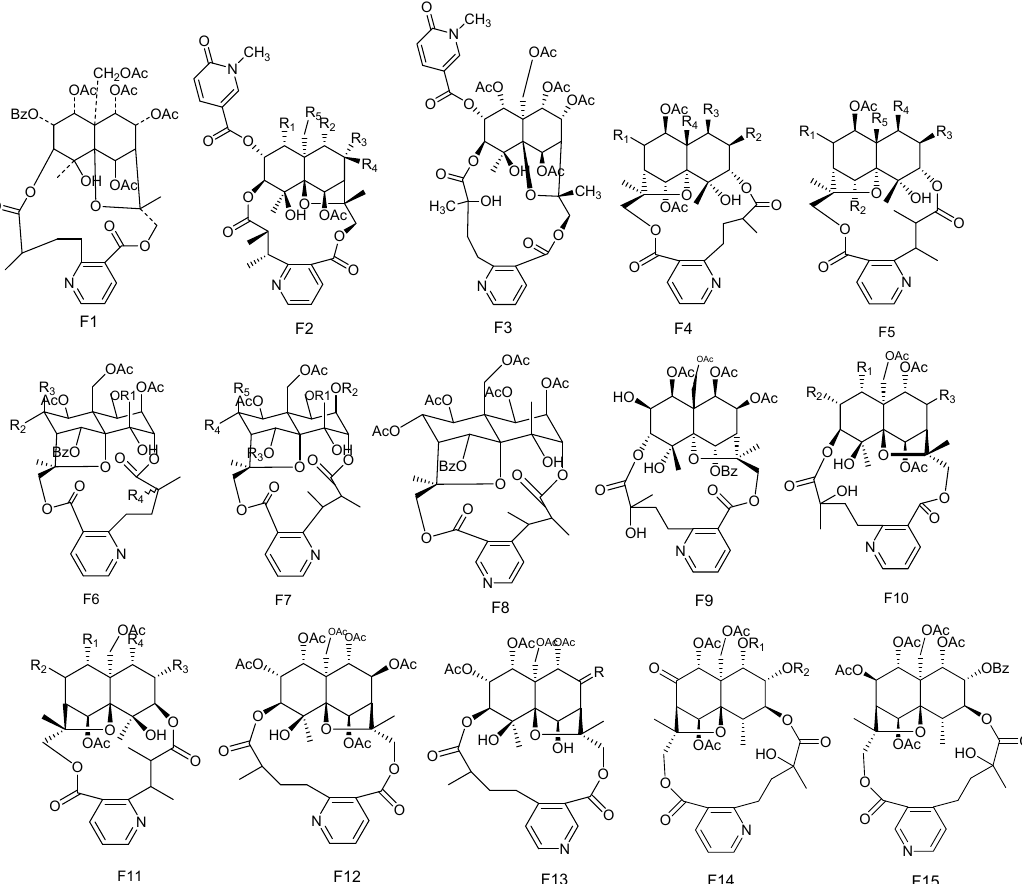
Figure 6. Fifteen types (F1–F15) of sesquiterpene pyridine alkaloids skeletons.